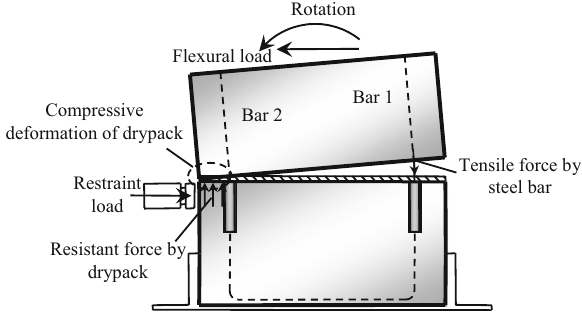
Fig. 13 Contribution of compressive deformation of dry pack to the rotation of the upper